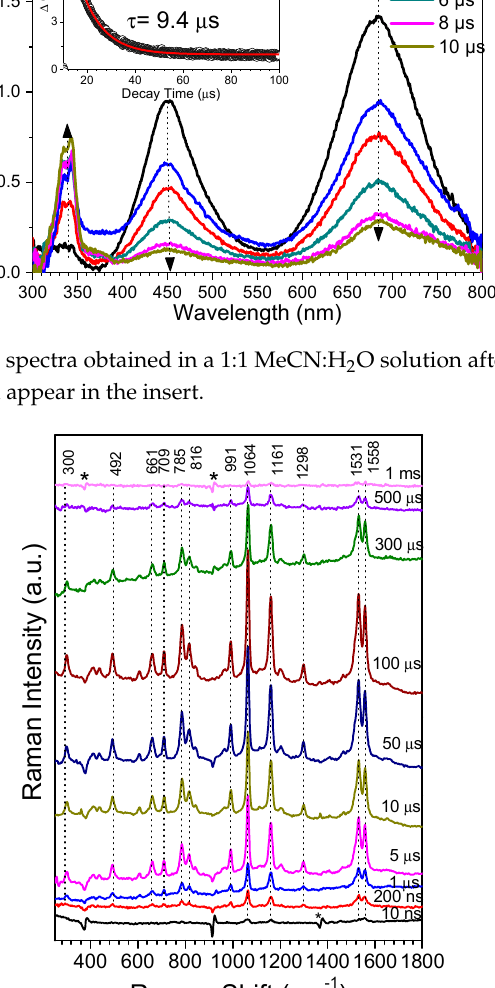
Figure 3. Shown are ns-TA spectra obtained in a 1:1 MeCN: H 2 O solution after 266 nm irradiation of DN. The kinetics at 450 nm appear in the insert.